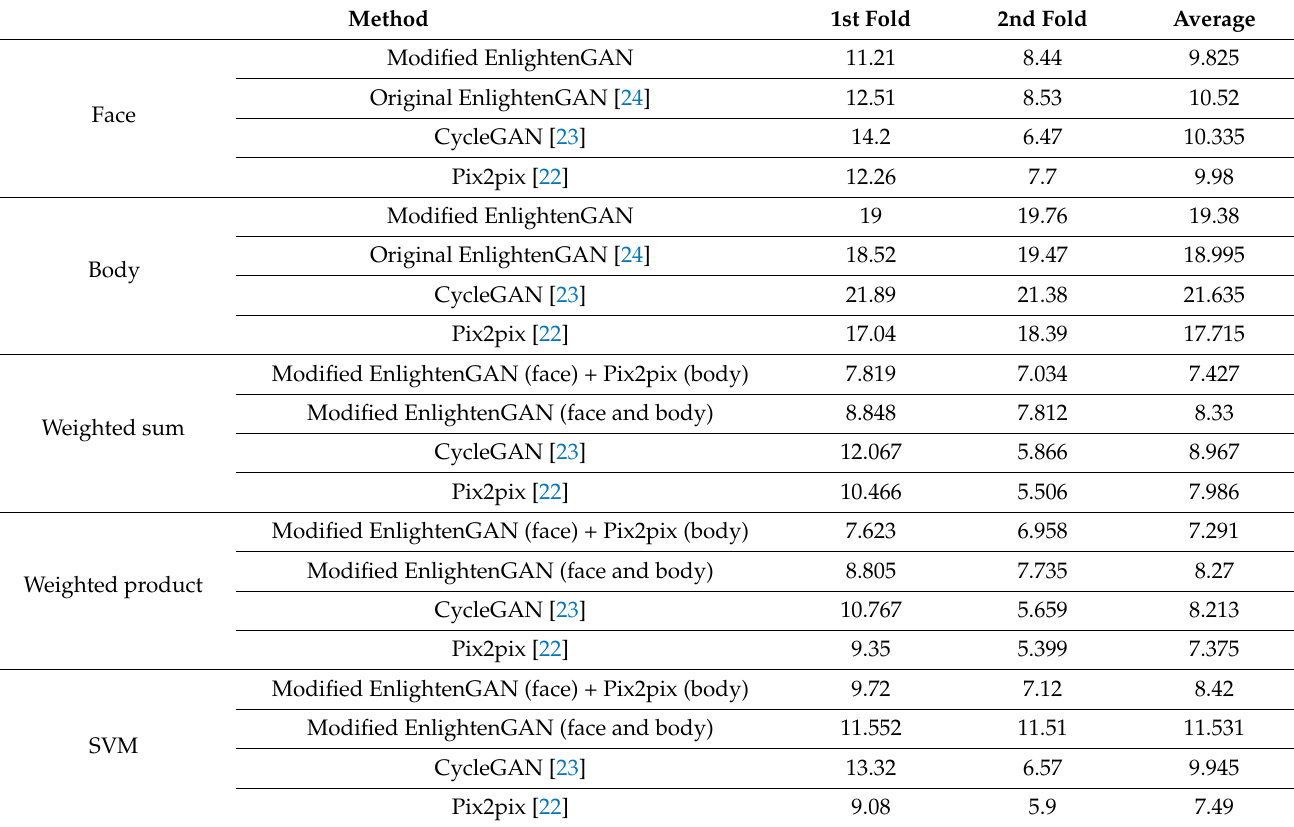
Table 10. Comparisons of EERs using our proposed method with those using state-of-the-art GAN-based methods (unit: %).